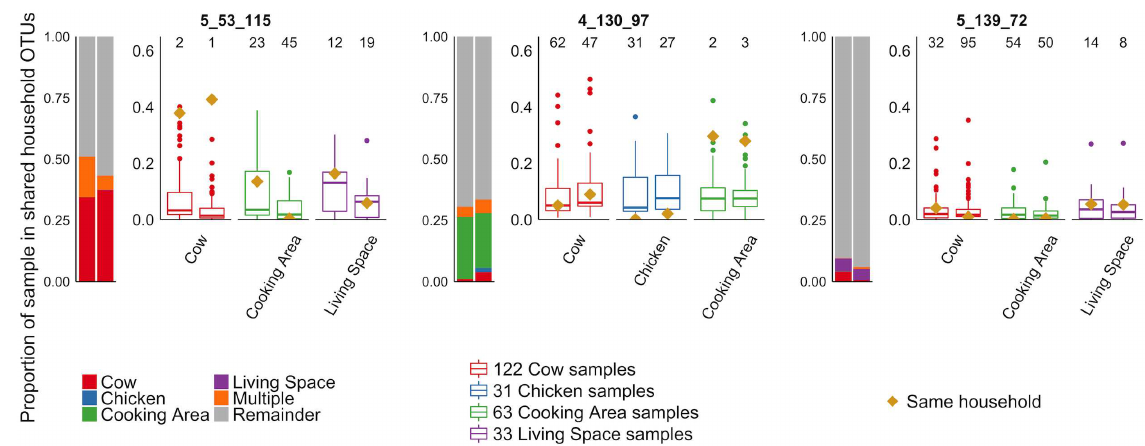
Fig 4. Proportion of microbiome sharing between children and other household samples in three households in western Kenya. Each household representedhere had two children,represented by the vertical bar and box plots. The bar graphs on the right side of each panel illustrate the proportionof microbes sharedbetweenthe child and their cow, chicken,cooking area, or living space. The box plots in each panel show the distribution of microbiomesharingbetween the child and samples from other households, comparedto the proportionshared with their own household sample, representedby a gold diamond. The number on top of each box plot representsthe rank of the sharingwithin the same household amongsharing values calculatedwith all other households(e.g., “1” indicatesa case where the sharing with the same household was the highest comparedto sharingwith any other households). The first panel shows a householdin which both children had a high level of microbiomesharingwith the cow in their householdcomparedto cows in other households. The second panel shows a household in which both childrenhad a high level of sharing of their gut microbiomewith the surface in the cooking area of their household. The final panelshows a household in which the childrendid not show sharing with any of their